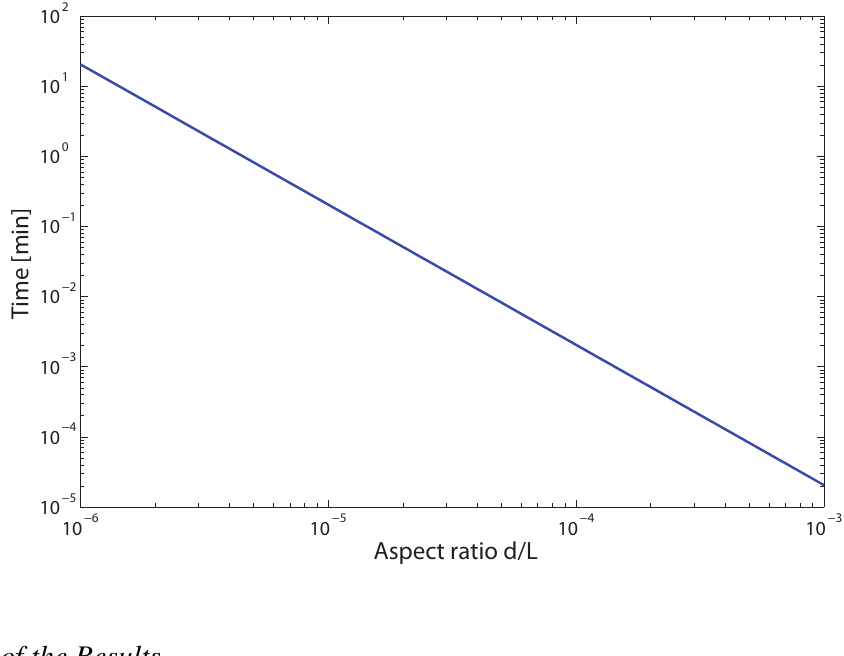
Figure 8. Filling time required for methane gas diffusion as a function of the aspect ratio d/L of the HC-PBF employed, in logarithm scales.